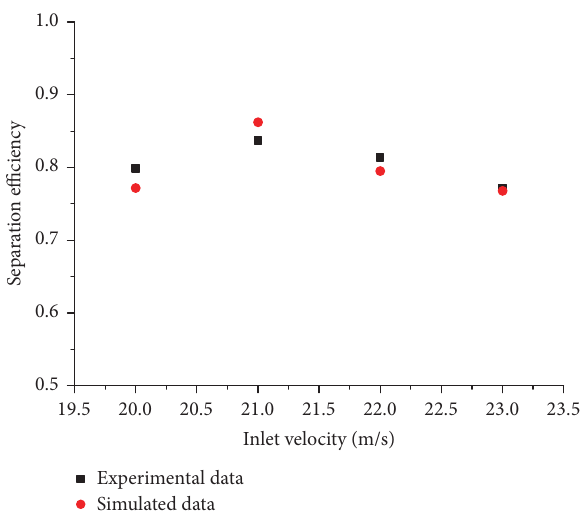
Figure 3: The comparison of the simulated data and the experimen- tal data.